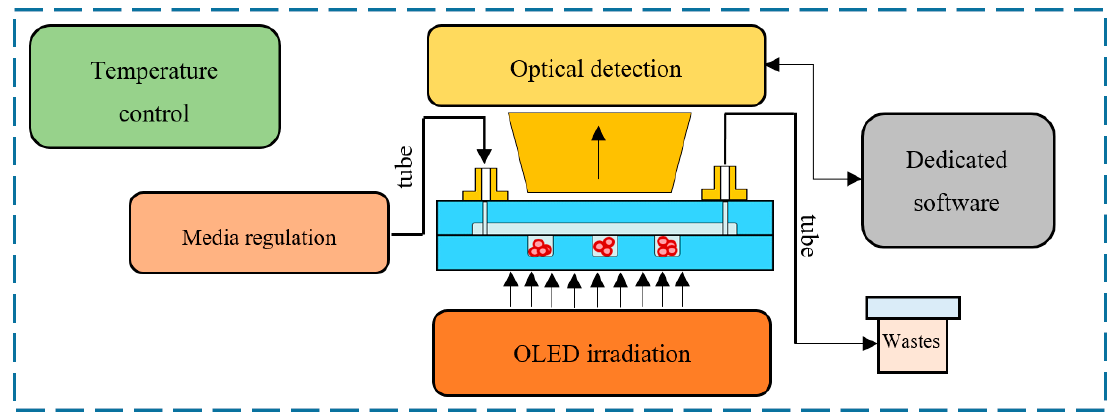
Figure 1. A schematic diagram of the lab-on-chip (LOC) platform.